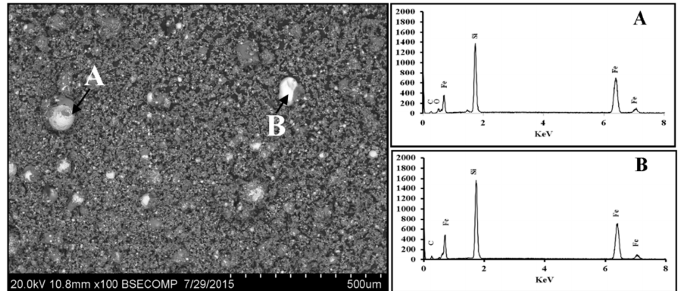
Figure 3. The presence of a large number of Fe-Si alloy droplets in a range of sizes across the specimen. The dark powder in the background is unreduced silica and or silicon carbide. Phases “A” and “B” represent ferro-silicon alloys produced in the